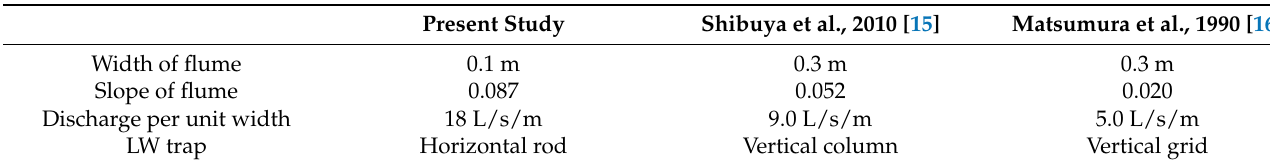
Table 3. Comparison of experimental conditions between present and previous studies.